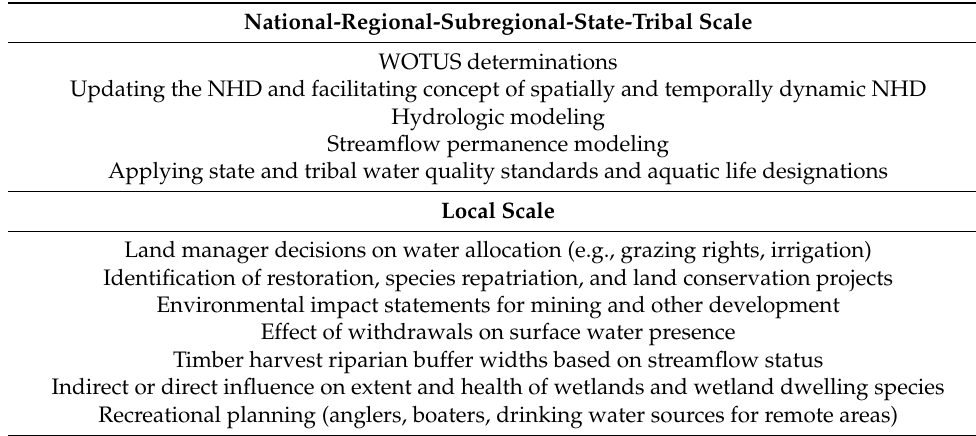
Table 3. Applications of incidental streamflow class data beyond collecting